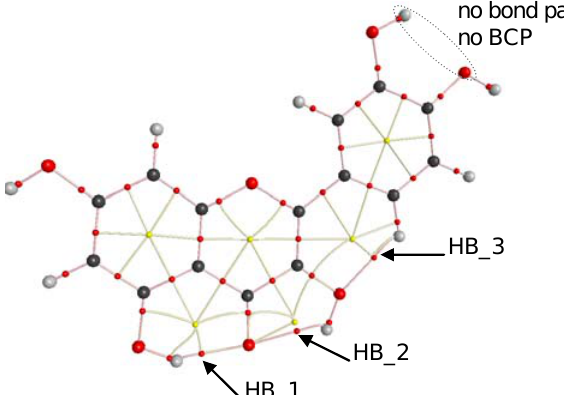
Figure 8. AIM analysis for flavonoid XIII (quercetin). Small red dots represent bond critical points, small yellow dots represent ring critical points, pink lines represent bond paths, yellow lines represent ring paths, and large dots represent attractors (atoms; red, oxygen; black, carbon and gray,